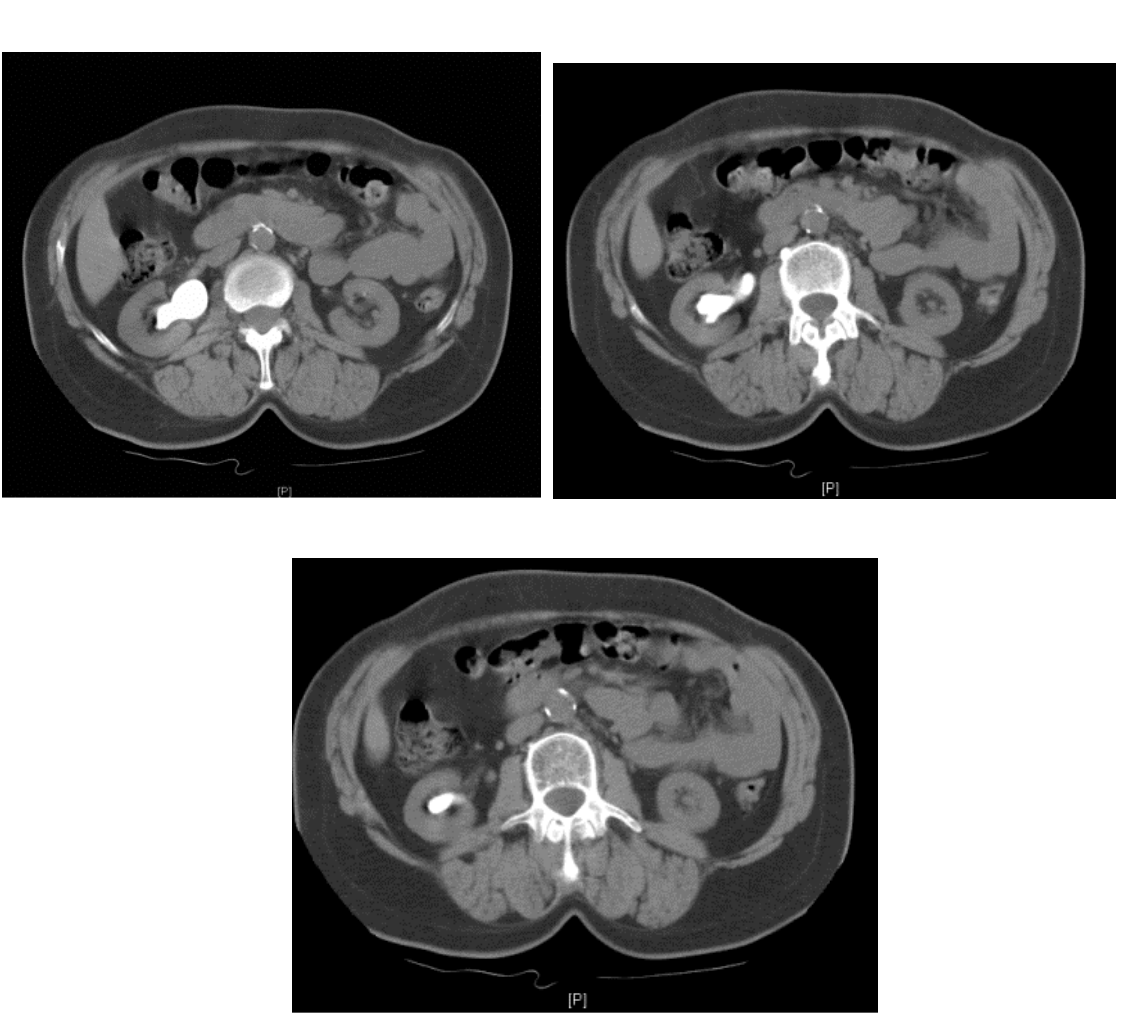
FIGURE 1. Computed Tomography with axial images through renal pelvis and ureteropelvic junction demonstrating large preoperative calculus